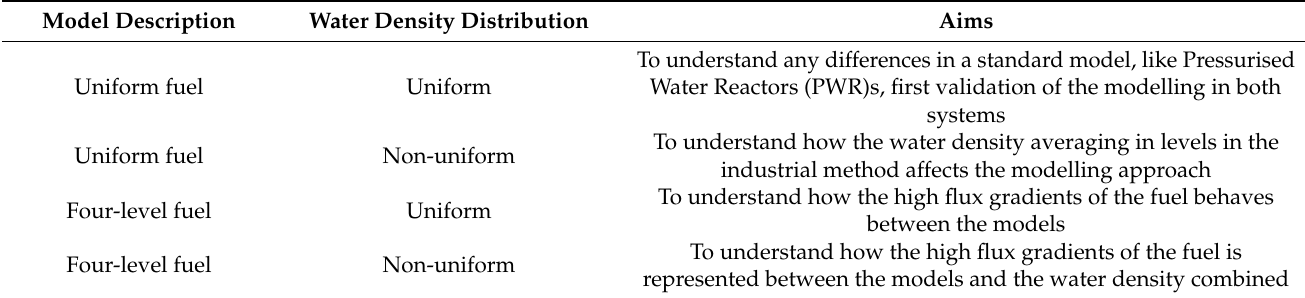
Table 2. Single assembly progressive test comparisons